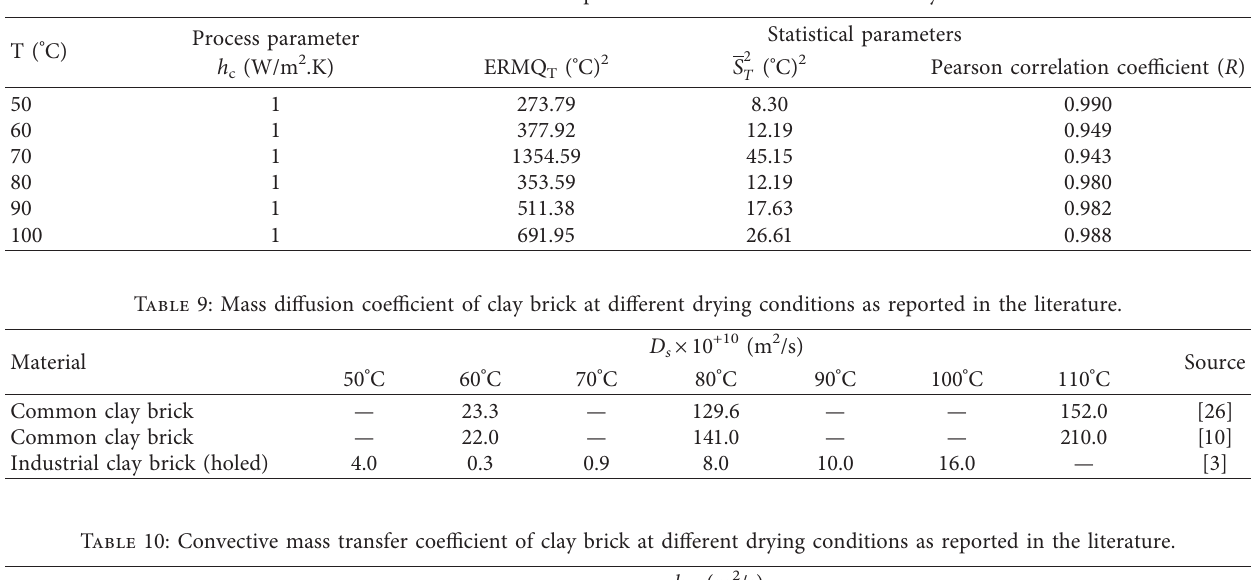
Table 8: Values of heat transport coefficients estimated numerically.